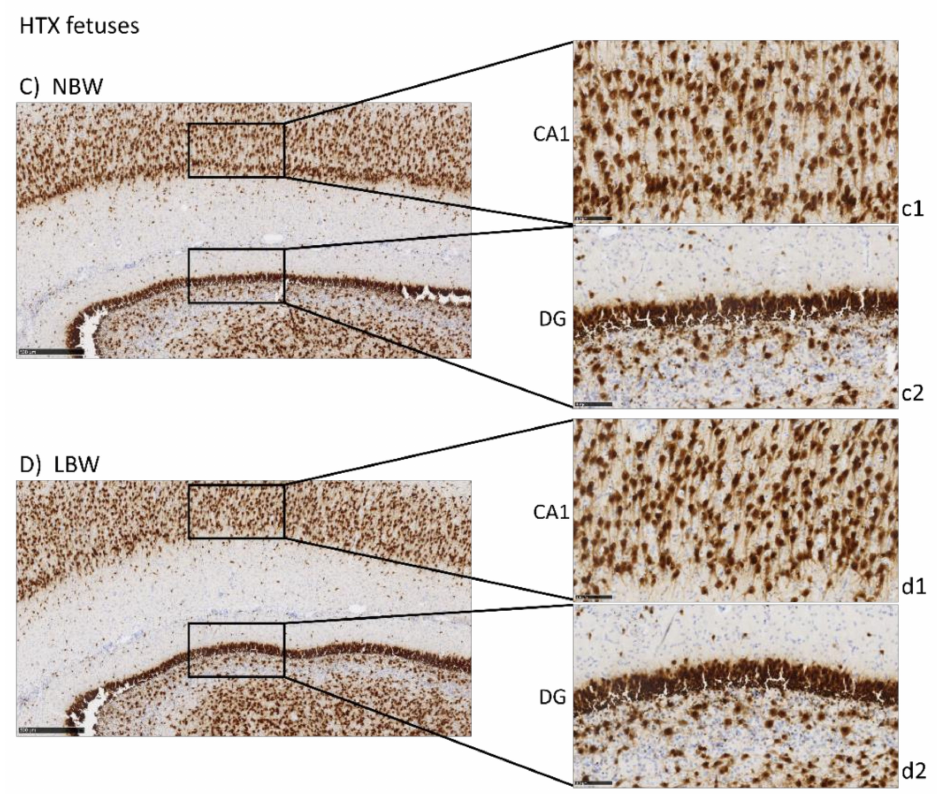
Figure 1. Effect of Intrauterine growth restriction (IUGR) on NeuN immunostaining on the hippocam- pus of fetuses whose mothers were not HTX-supplemented ( A , B ) or were HTX-supplemented ( C , D ). Representative images show the mature neurons immunostained with the NeuN antibody. Panels are magnifications of the CA1 ( a1 – d1 ) and GD ( a2 – d2 ) areas shown using black boxes. Scale bars: